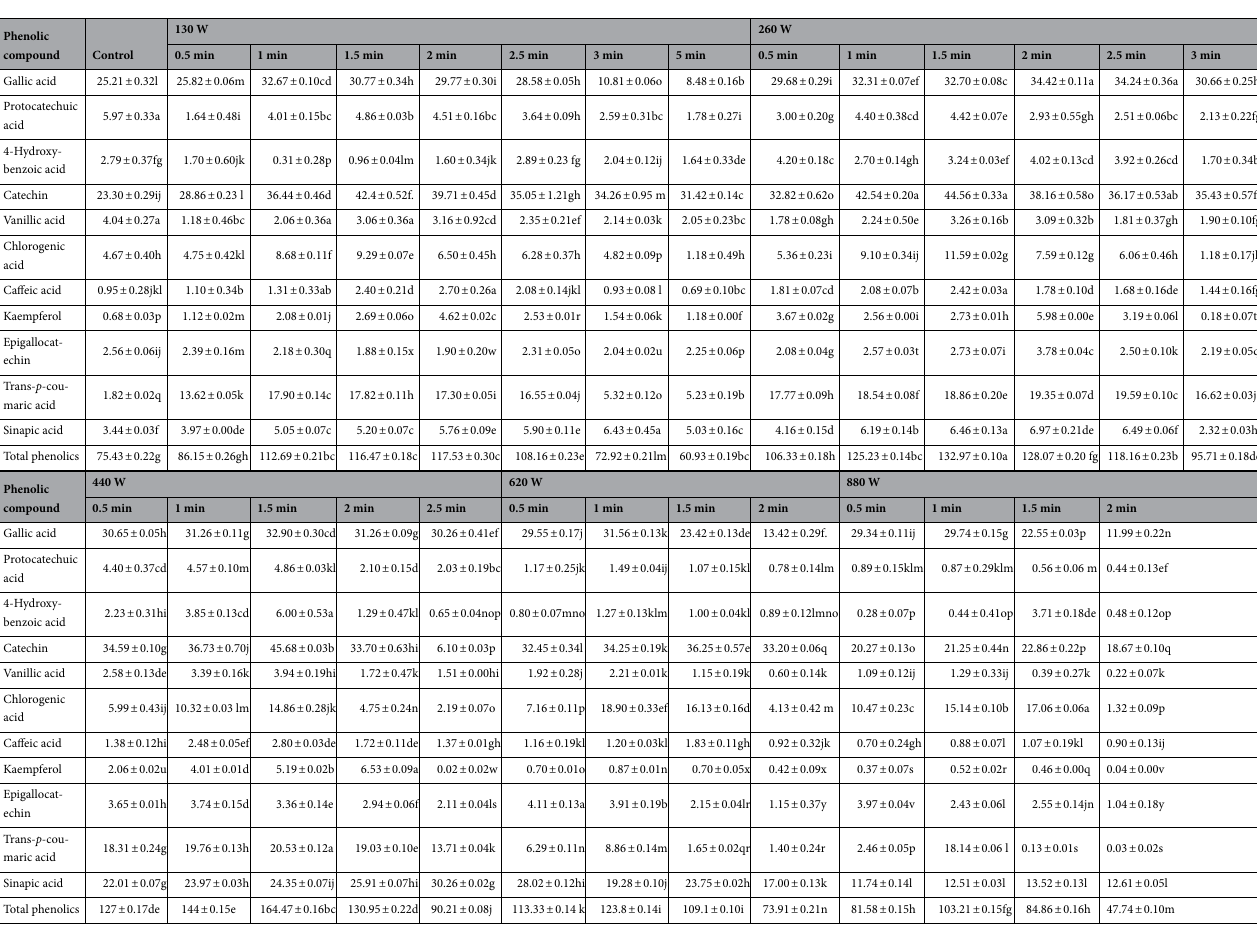
Table 2. Phenolic compounds of rice bran treated in microwave oven (µg/g). Values are means ± standard deviations ( n =